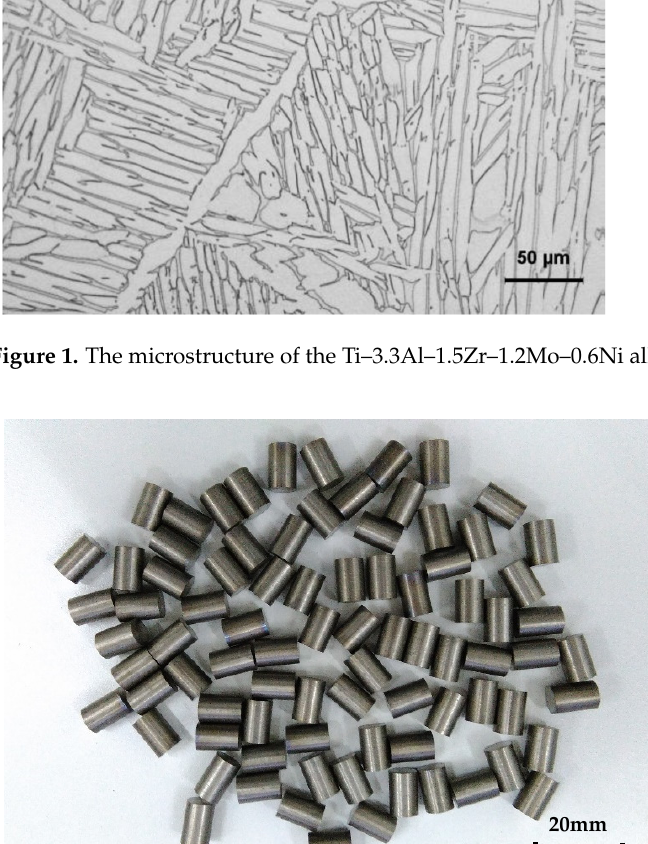
Figure 2. The thermal simulation compression specimens.